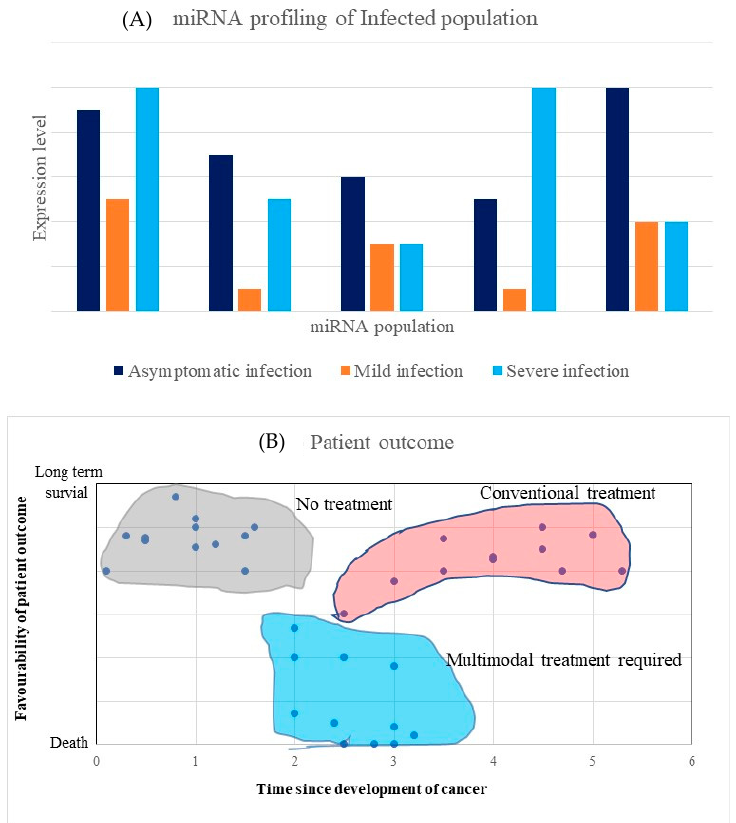
Figure 3. V-miRNA biomarkers in precision oncology. ( A ) v-miRNA can be profiled in an